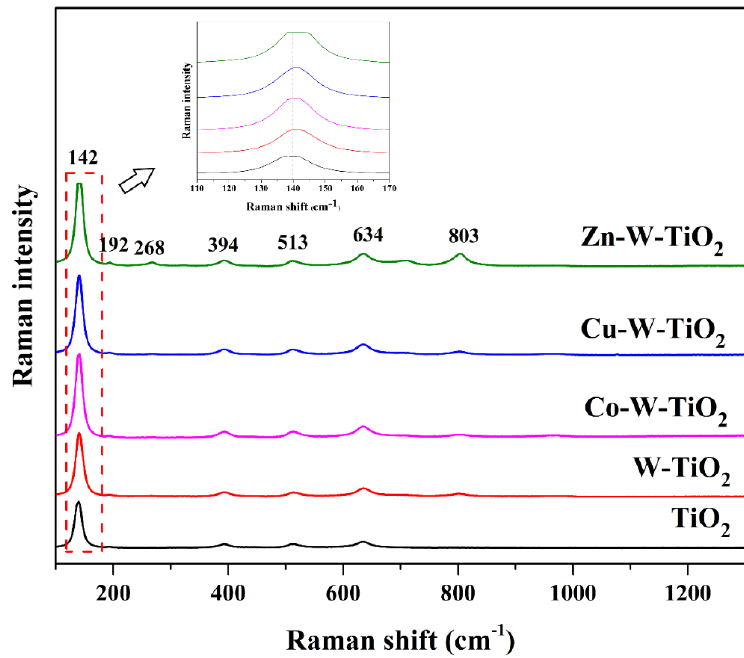
Figure 5. Raman spectra of TiO 2 , W − TiO 2 , Co − W − TiO 2 , Cu − W − TiO 2 , and Zn − W − TiO 2 .